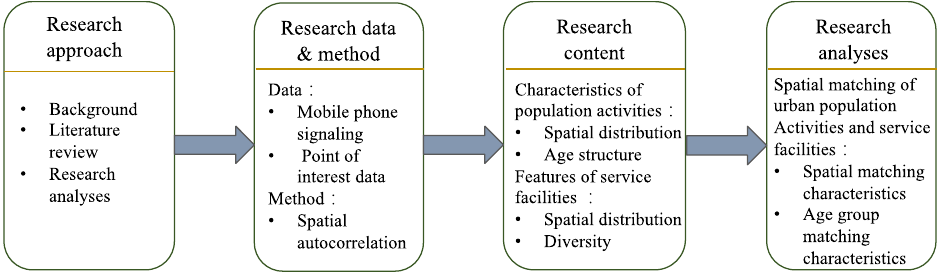
Figure 1. Research framework for spatial matching of service facilities and population activities.